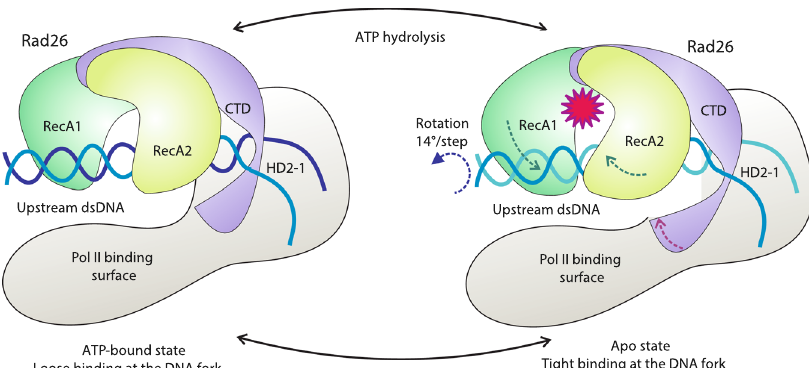
Fig. 7 Mechanism of Rad26-assisted Pol II forward translocation on a damaged DNA template. The RecA1 and RecA2 domains are shown in dark and light green, CTD and the insertion helices are shown in purple, Pol II in gray, the DNA strands in light and dark blue. The directions of the swing motions of the ATPase domains and the rotation of the upstream DNA duplex are depicted by dashed arrows. The red star indicates the ATP